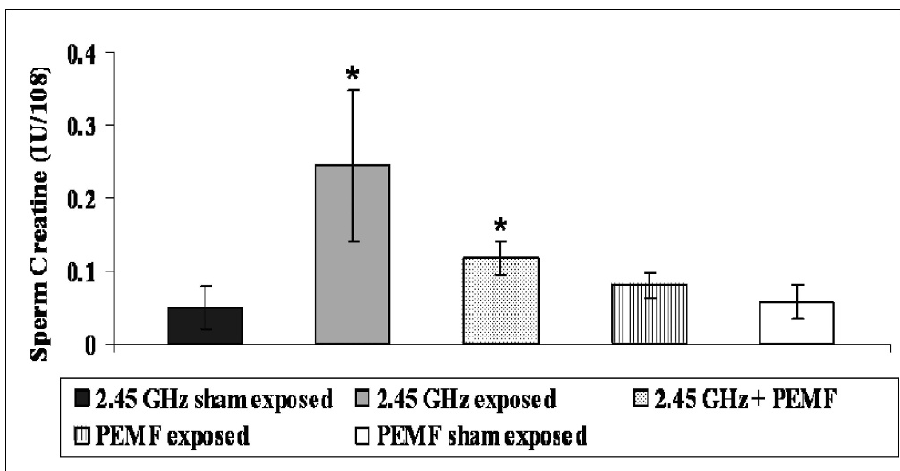
Figure 6 - The five columns represent the CK activity distribution in the sperm fractions of the various groups. The results are expressed as IU/10 8 spermatozoa ¡ standard deviation. All of the determinations were performed in triplicate.